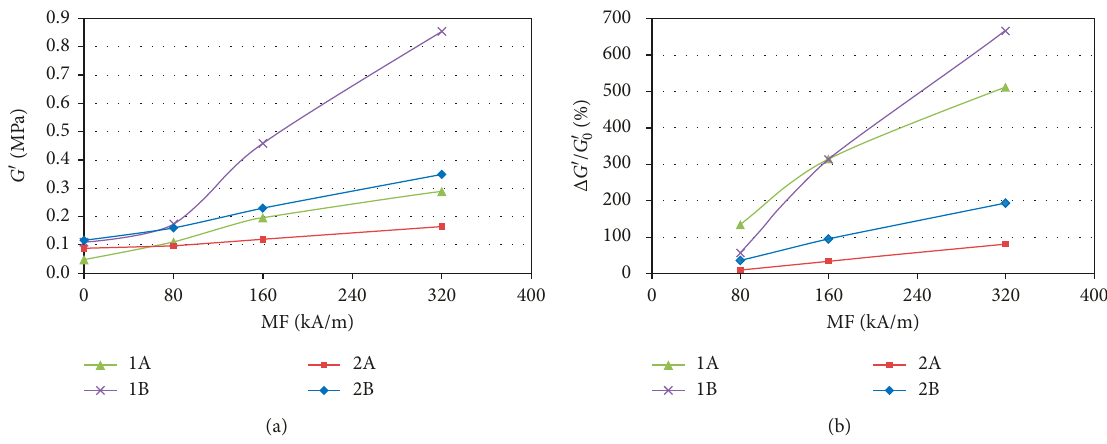
Figure 2: Storage modulus G and relative MR effect for samples under different magnetic field strengths. ′